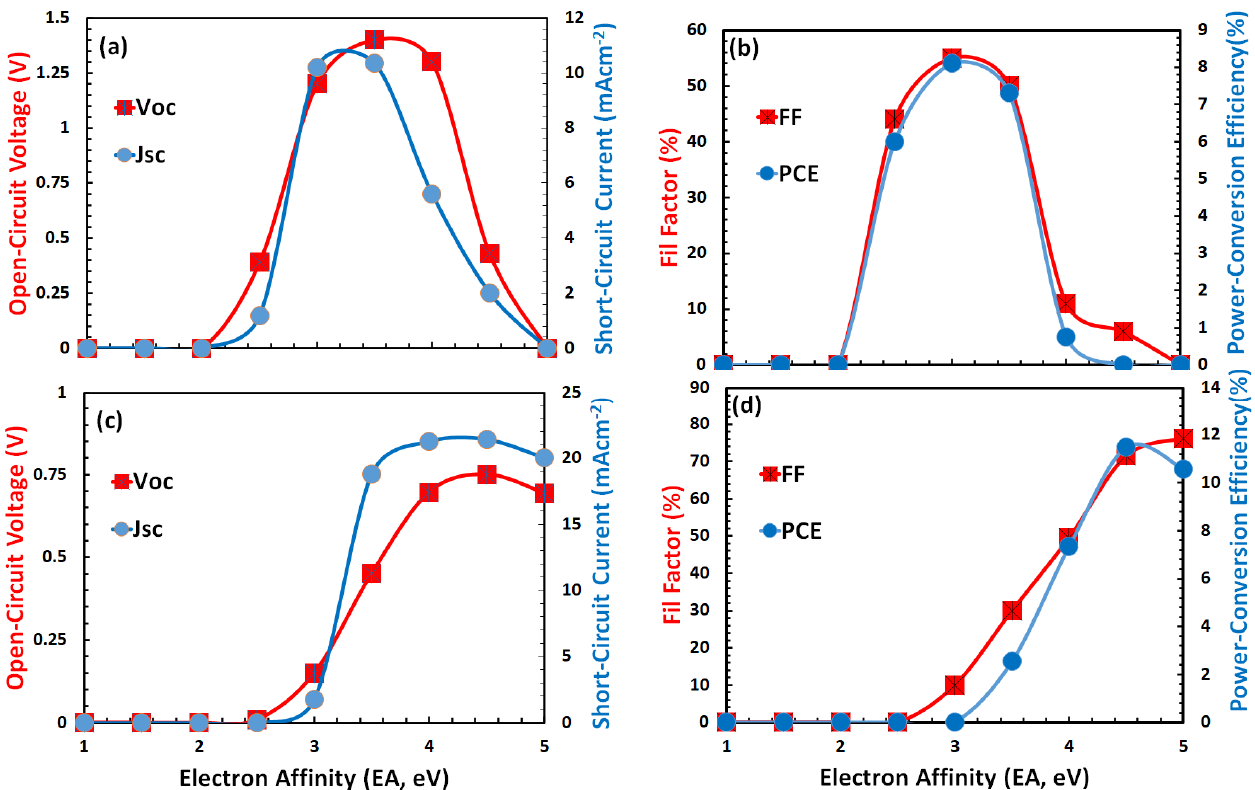
Figure 3. ( a ) Open-circuit voltage, short-circuit current, ( b ) fill factor, and power conversion efficiency of hole transport layer as a function of electron affinity. ( c ) Open-circuit voltage, short-circuit current, ( d ) fill factor, and power conversion efficiency of electron transport layer as a function of electron affinity for Cs2TiBr6-based solar cell.